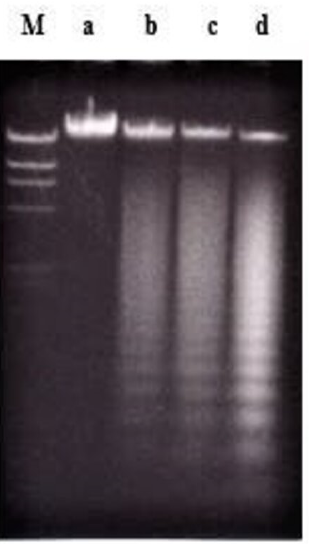
canthal-induced apoptosis in CEM-SS cells at 24 h. Zinc sulphate and cycloheximide prevented